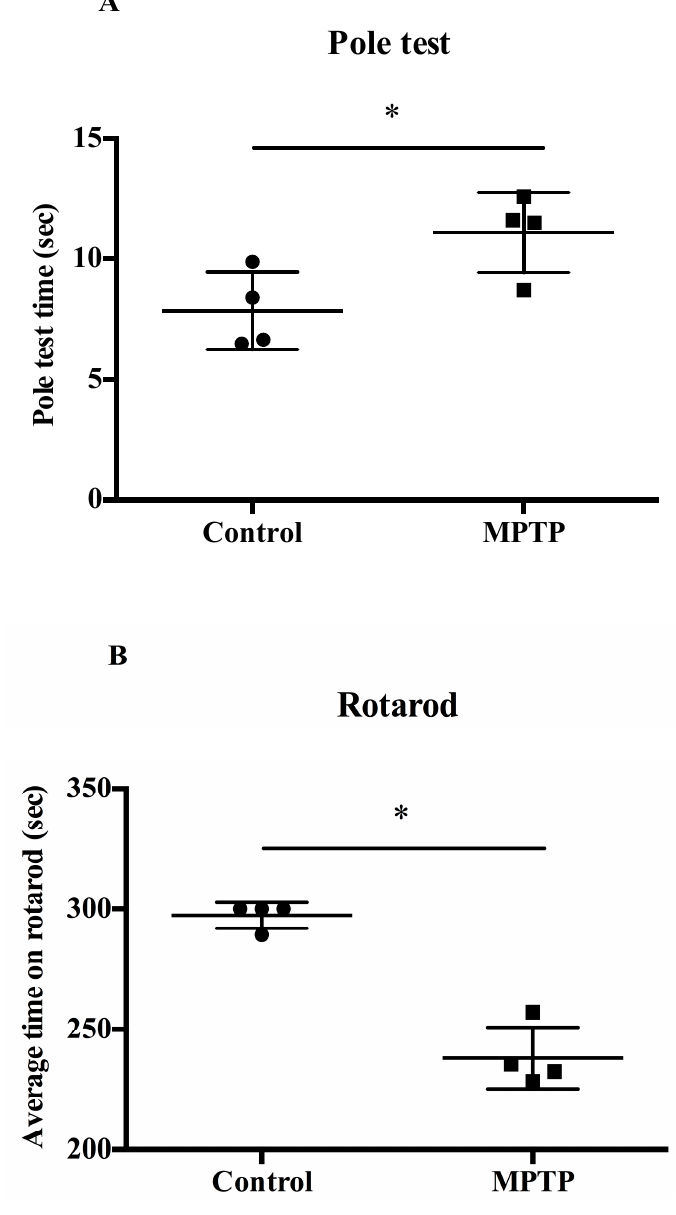
Figure 1. Measuring the exercise capacity of 1-methyl-1,2,3,6-tetrahydropyridine (MPTP)-induced model mice in a ( A ) pole test and ( B ) rotarod test. Values are expressed as mean ± standard error of the mean (SEM); * indicates a p -value < 0.05.